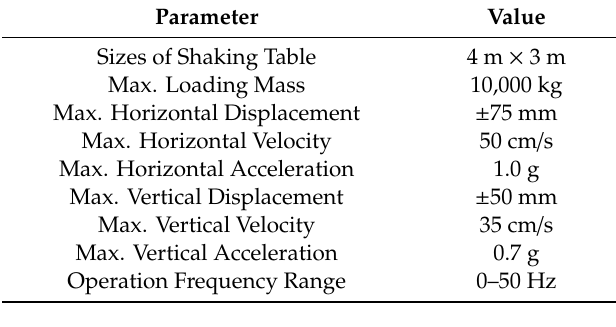
Figure 2. The elliptic underwater vibration table in the flume.